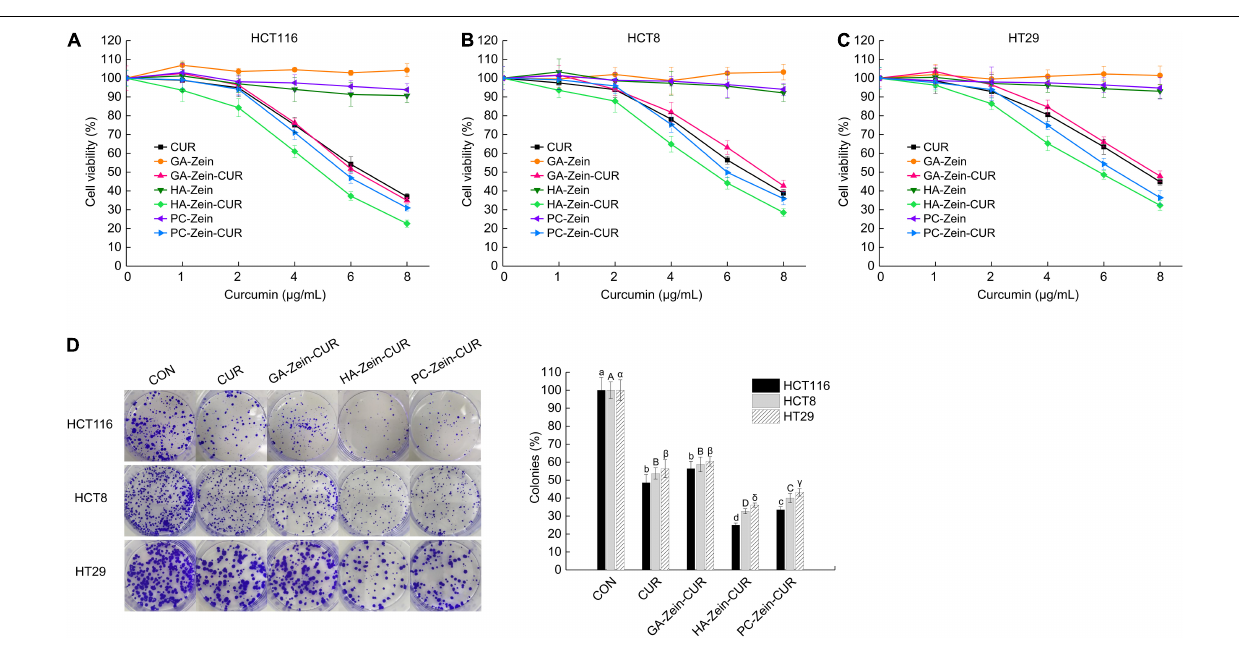
nearly disappeared in the HA-Zein-CUR and PC-Zein-CUR.